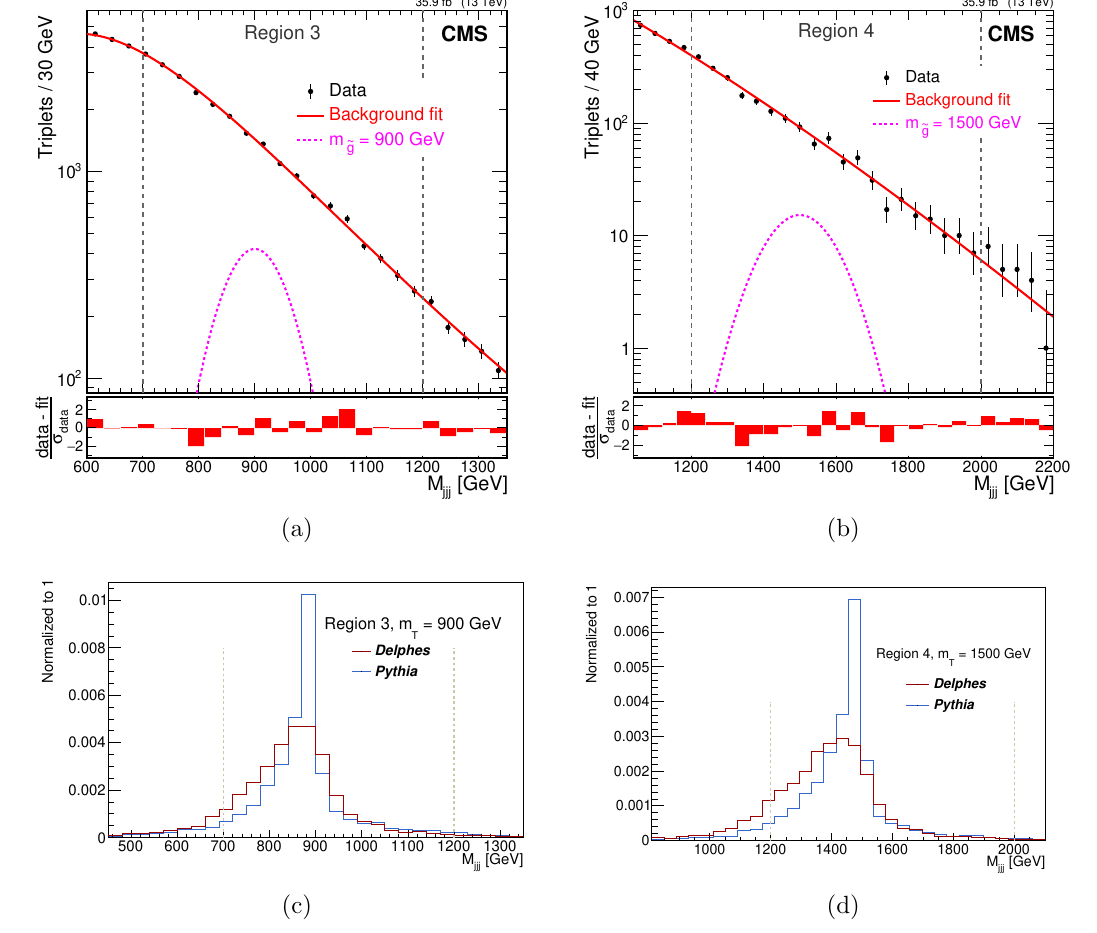
Figure 8. Mass distributions for two of the mass regions. The distributions in (cid:12)gure (a) and (b) are produced by CMS [49] while the bottom (cid:12)gures are the corresponding ones for m (cid:17) = 5